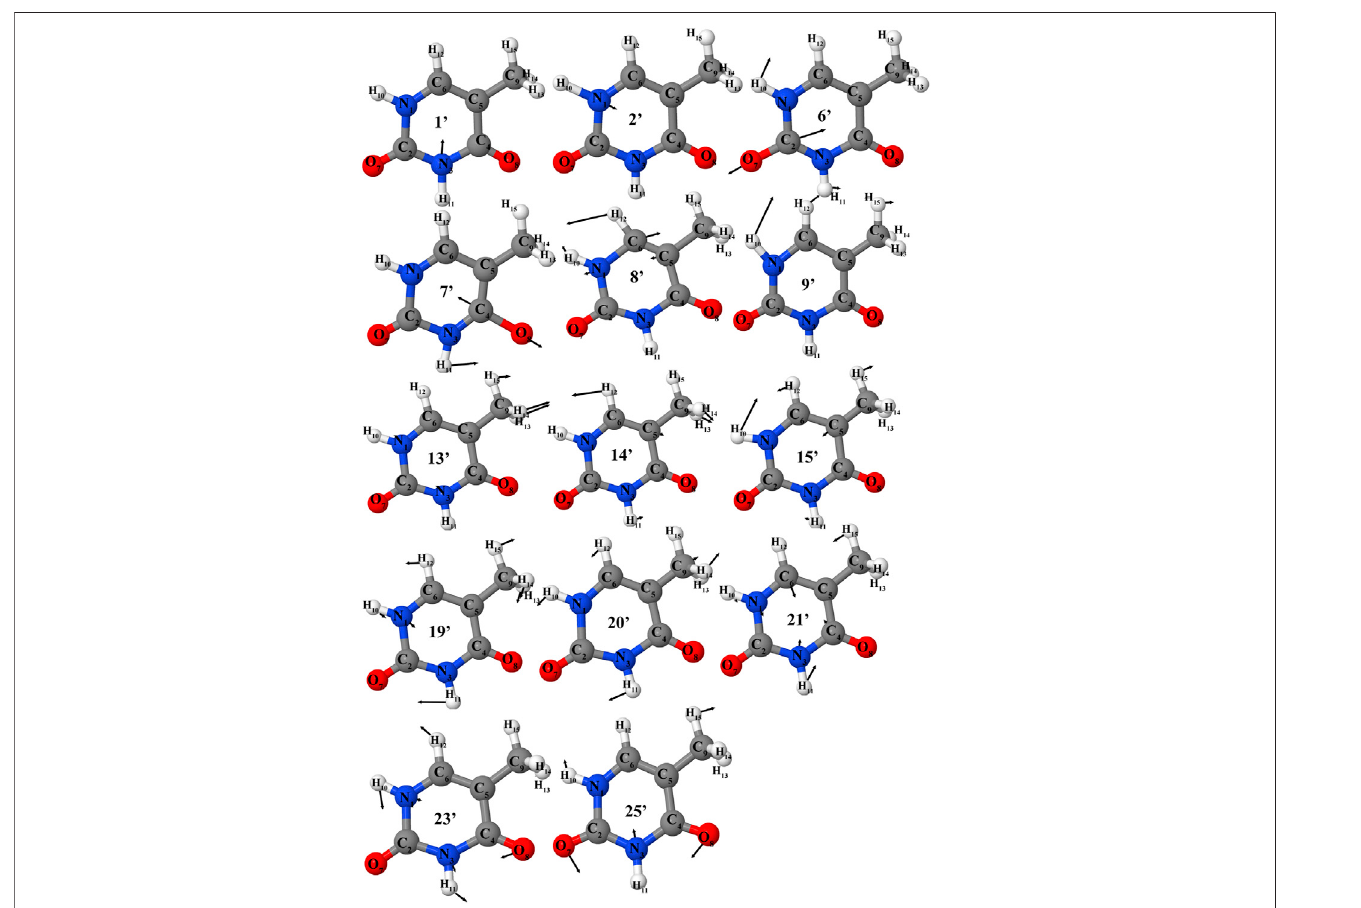
FIGURE 3 | Selected vibrations of the thymine (in cation normal modes representation) corresponding to most intense transitions in IR or photoelectron spectra.